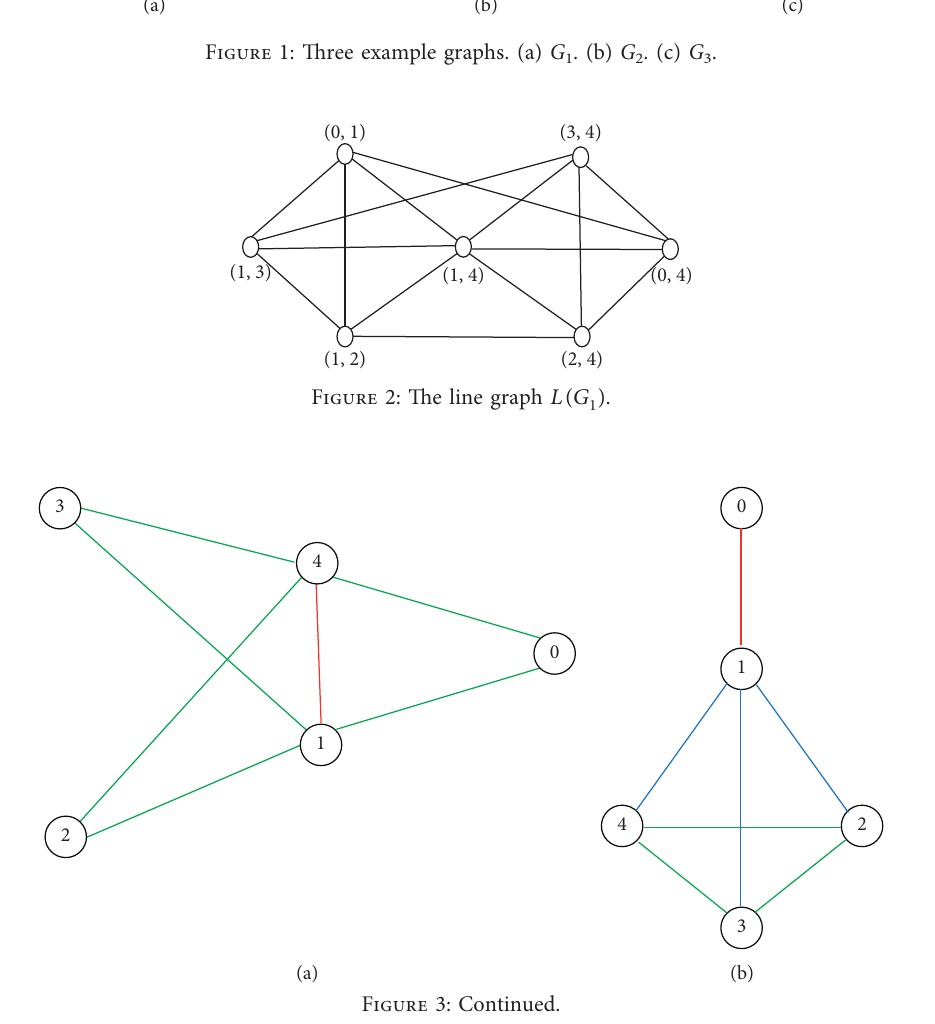
Figure 1: Three example graphs. (a) G